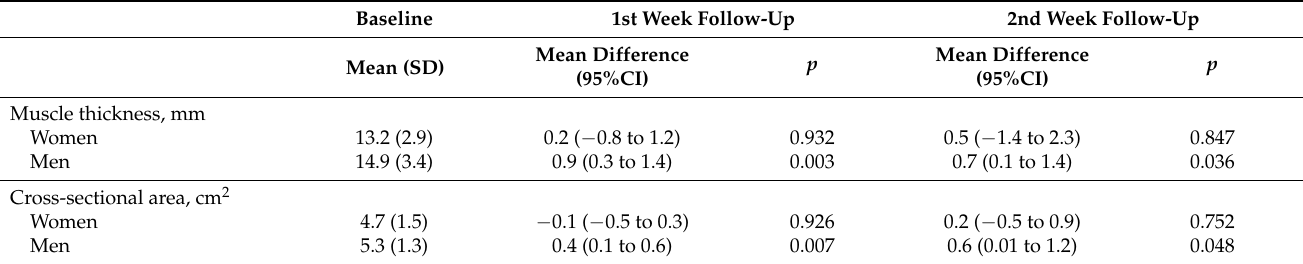
Table 3. Changes in muscle thickness and cross-sectional area of the rectus femoris muscle assessed through ultrasound during hospitalization in the post-acute care unit according to sex distribution (n = 40). Baseline 1st Week Follow-Up 2nd Week Follow-Up Mean Difference Mean Mean (SD)